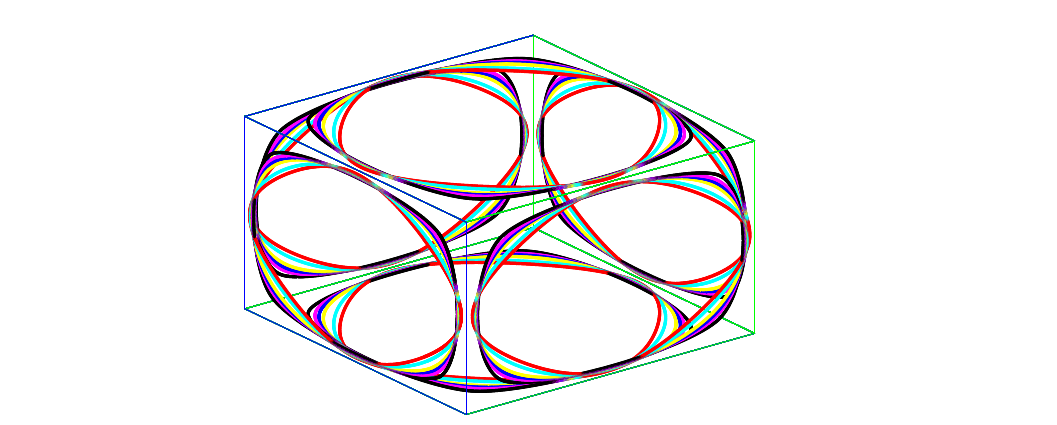
Figure 20. 3D cube construction using TRBS.